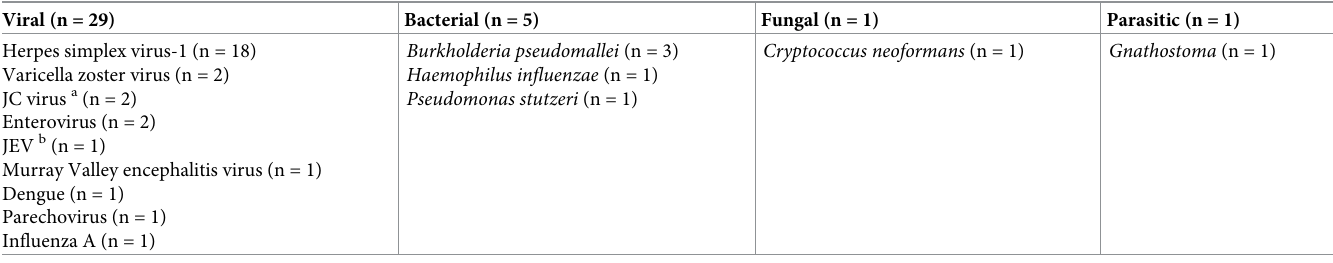
Table 6. Laboratory-confirmed aetiology of patients with